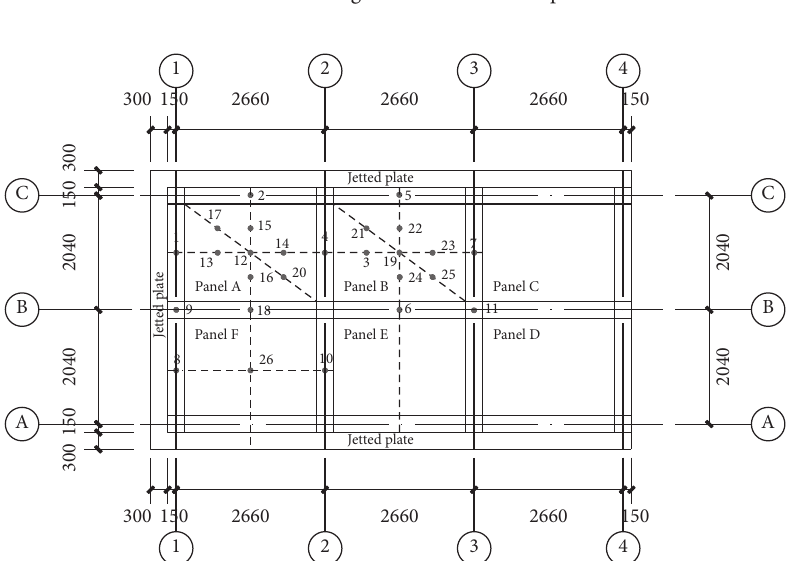
Figure 9: Displacement measure points at the top surface of the AMH